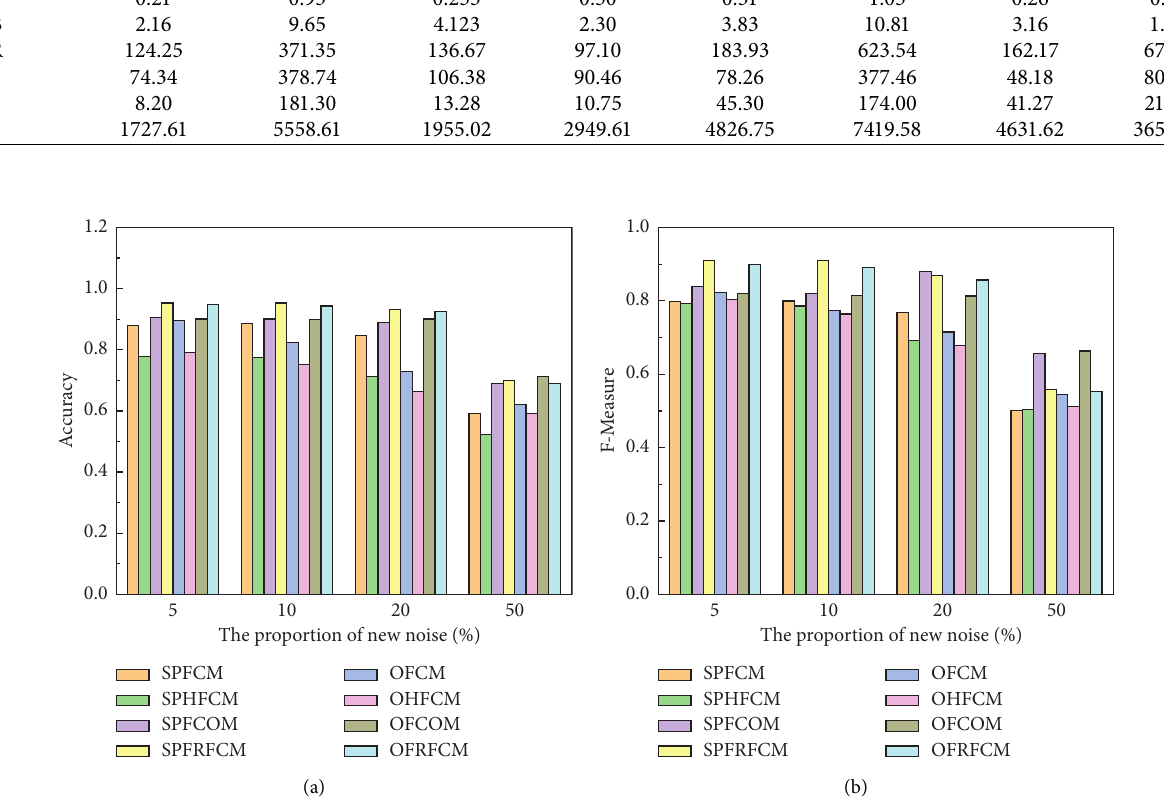
Figure 3: Robustness comparison on the IR dataset. (a) Accuracy; (b) F-Measure.